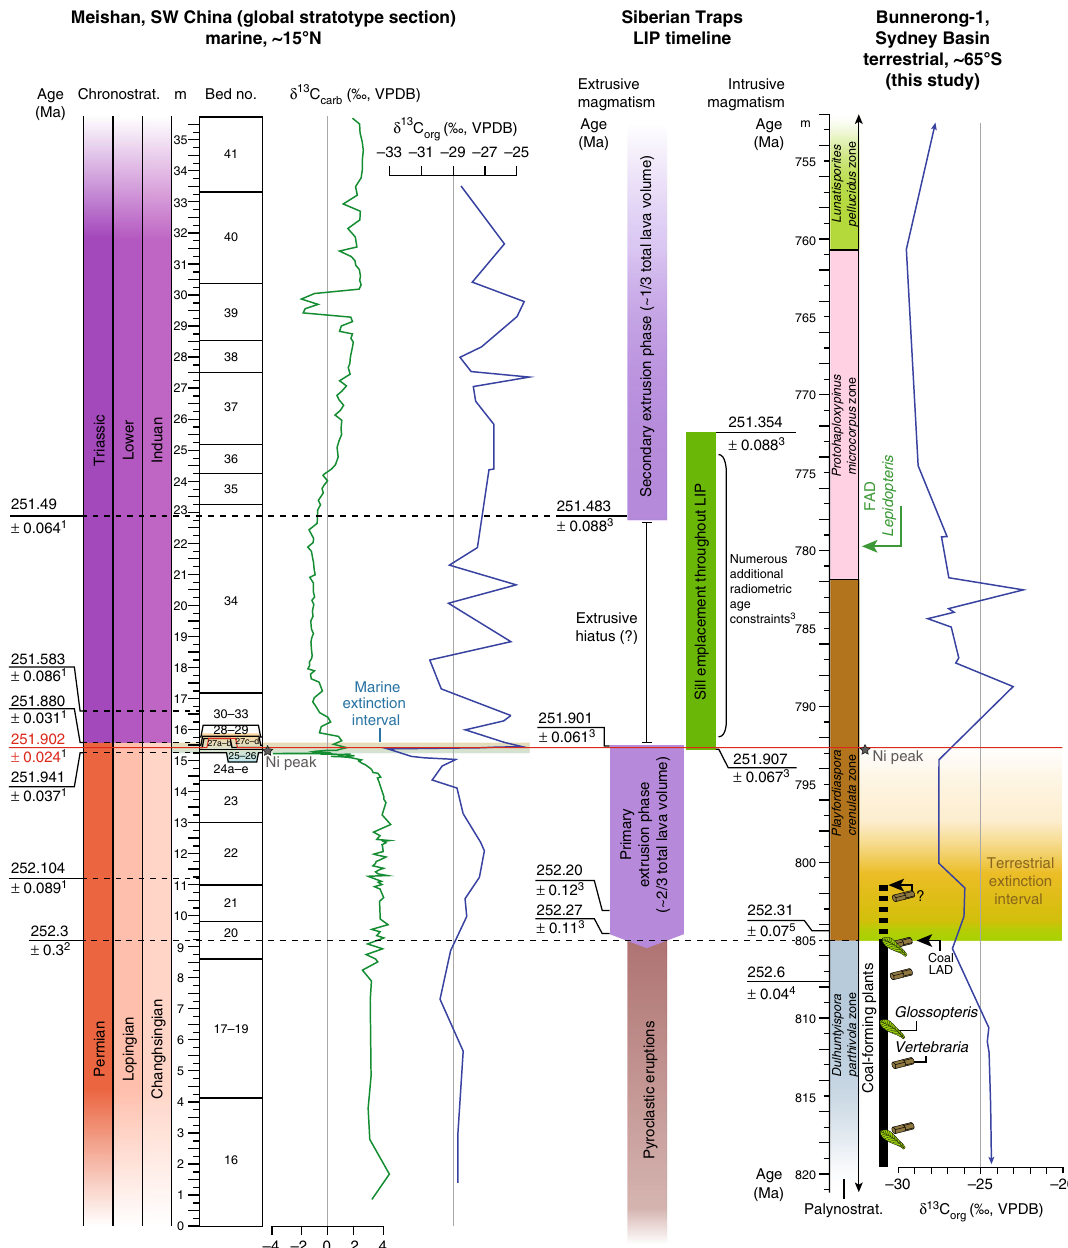
Fig. 5 Age correlations of the PTB and EPE. Correlations shown between the marine Permian – Triassic global stratotype section at Meishan, the terrestrial Sydney Basin succession, and the magmatic phases of the Siberian Traps Large Igneous Province. All absolute age uncertainties are at 2 σ level; 1 = ref. 2 , 2 = ref. 79 , 3 = ref. 50 , 4 = ref. 33 , 5 = this study. FAD = fi rst appearance datum, LAD = last appearance datum. Palaeolatitudes from ref.